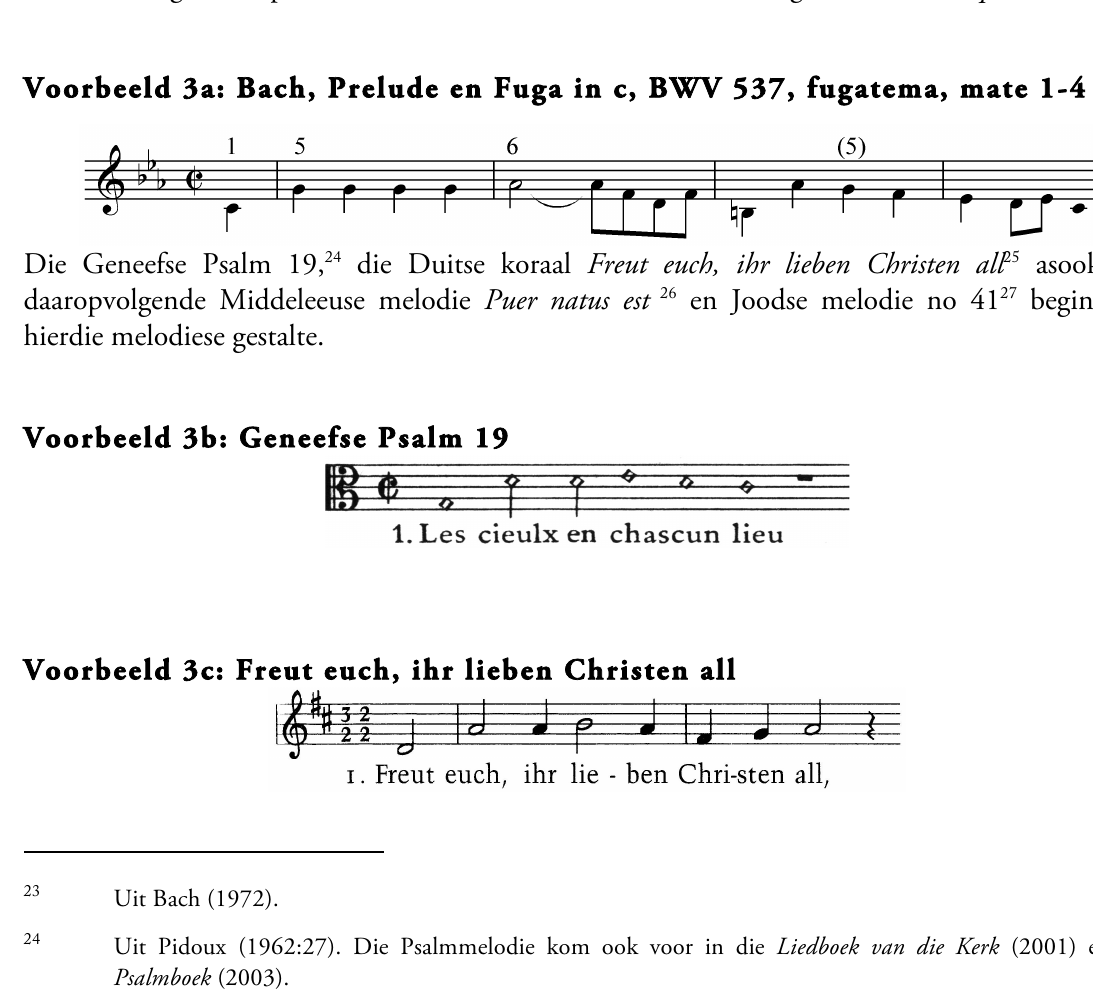
ooreenkomstige melodieë en selfs volledige ooreenkomstige liedtipes in die liturgiese gesange aangetref word. Die nog bestaande liedere en kantillering van die Oosterse Jode mag moontlik volgens Sendrey en Norton ’n direkte skakel met die Psalms van antieke Israel wees